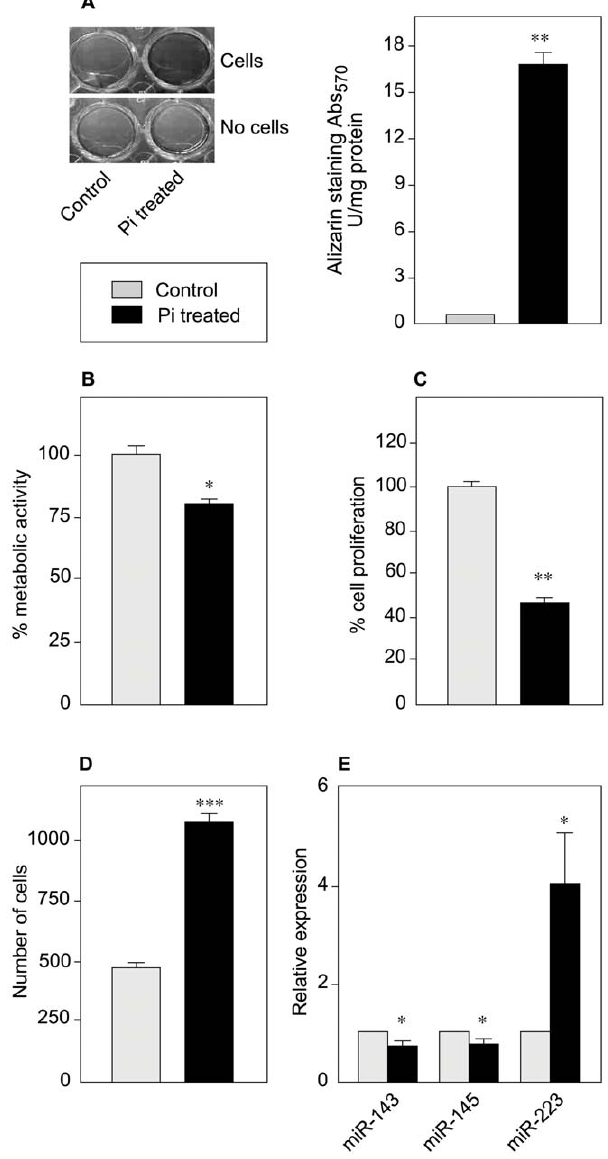
Figure 1. Physiological and molecular effects of Pi. VSMCs were cultured for 10 days in DMEM supplemented with 1% FBS in the presence or absence of 3.5 mM Pi. ( A ) A representative photograph of a calcification assay using alizarin staining, indicating greater calcification in Pi treated cells and the corresponding quantification. Alongside a control with cells incubated at 1.1 mM Pi and to check for non-specific calcium deposition, we also ran a cell-free control with the same Pi concentrations. ( B ) The VSMCs’ metabolic activity was studied in a WST- 1 colorimetric assay. Cells treated with 3.5 mM Pi showed low metabolic activity. ( C ) VSMC proliferation was measured in a BrdU ELISA. ( D ) The migration rate of VSMCs was determined using Boyden chambers and was found to be twice as high in Pi-treated VSMCs than in control cells. ( E ) Expression of miR-143, miR-145 and miR-223 was measured by qPCR. Data are represented as the mean of two or three independent experiments in triplicate.